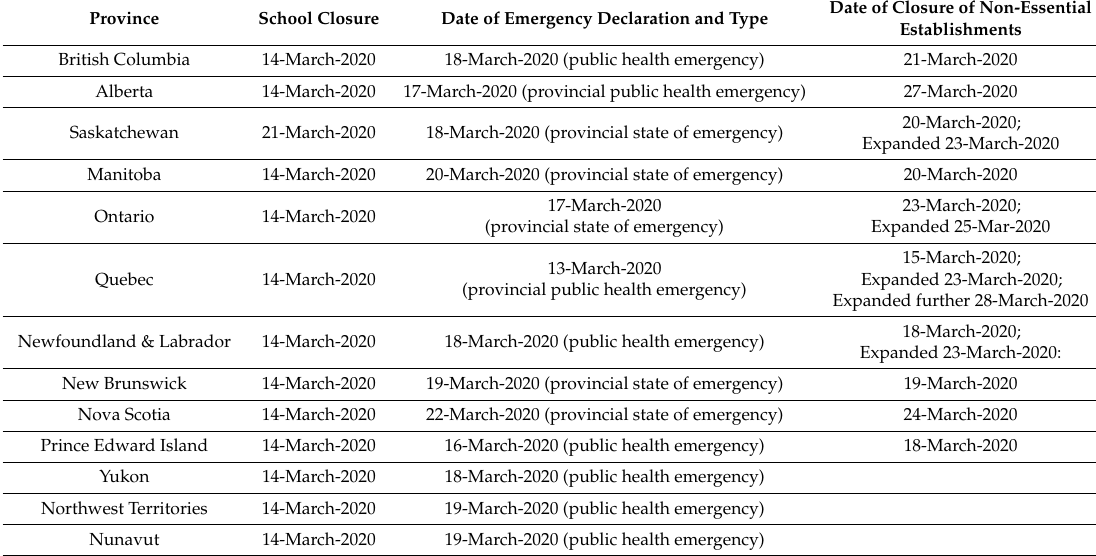
Table 1. School closure, emergency and public health emergency declarations in Canada by province and